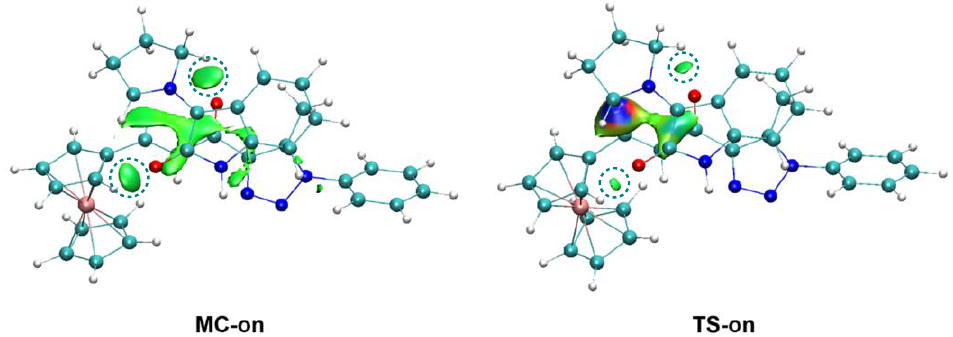
Figure 7. IGM- δ g inter 0.010 a.u. ( MC-on ) and 0.018 a.u. ( TS-on ) isosurfaces, represented with a blue- green-red color-code in the range of −0 .08 < (sign) λ 2 ρ < 0.08 a.u. The attractive IGM- δg inter surfaces associated with the two HBs are highlighted by a line-dashed green circle.